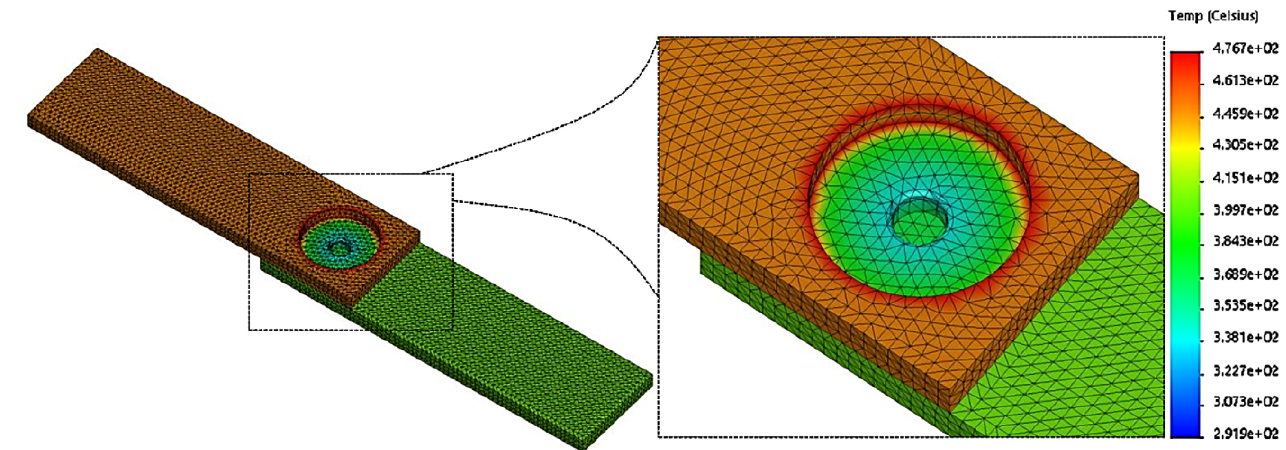
Figure 12. Temperature distribution in finite element simulation of SSM6061 aluminum alloy during FSSW process. Table 7. Summary of transient thermal characteristics of FSSW in previous investigations.